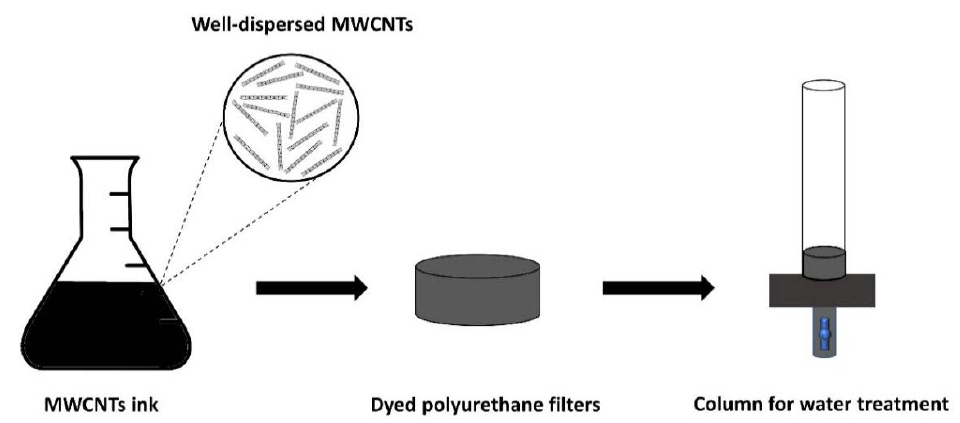
Figure 6. Schematic diagram for sorption experiments using a water treatment column.